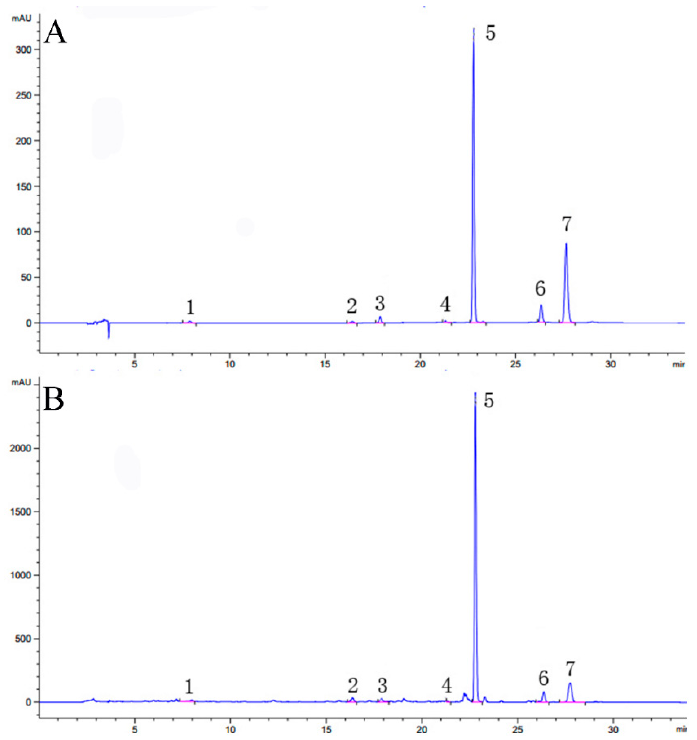
Figure 5. Peaks identification: ( A ) Liquid chromatogram of reference substance, ( B ) Liquid chromatogram of sample. ( 1 ) peucedanol; ( 2 ) xanthotoxin; ( 3 ) bergapten; ( 4 ) imperatorin; ( 5 ) praeruptorin A; ( 6 ) praeruptorin B; ( 7 ) praeruptorin E.